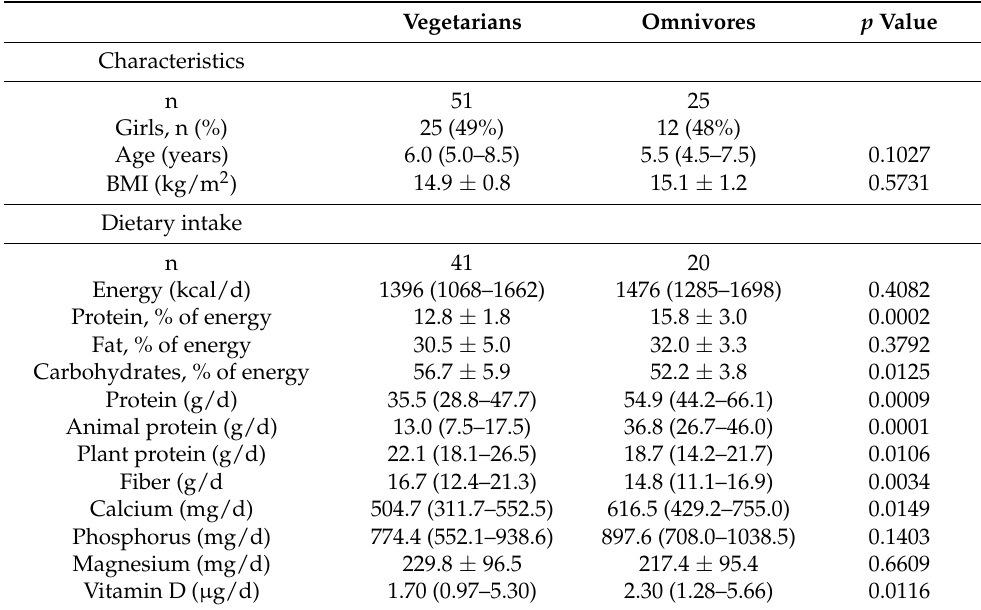
Table 1. Characteristics and dietary intake of energy, macro-, and micronutrients in vegetarian and omnivorous children.